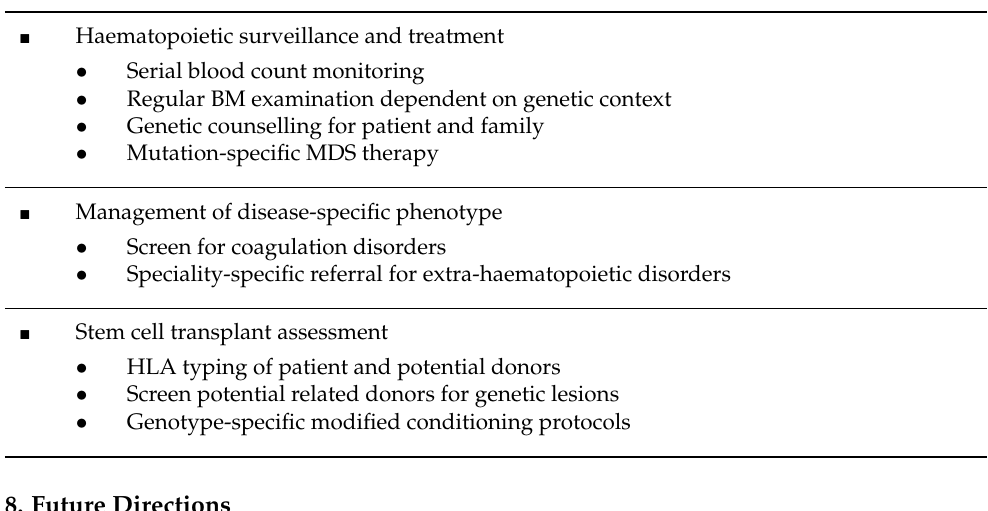
Table 3. Key management principles for patients with germline MDS